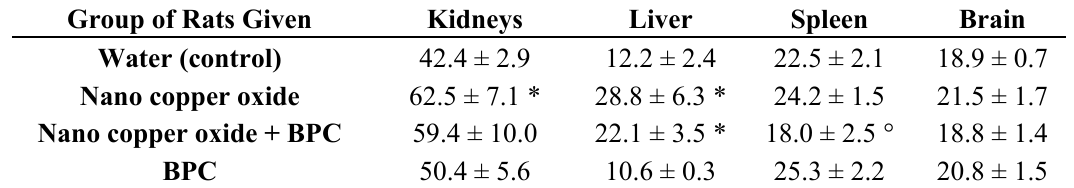
Table 1. Copper content of kidneys, liver, spleen and brain (mcg/g of dry-frozen tissue) of rats after repeat intraperitoneal injections of copper oxide nano-suspensions and/or oral administration of the bioprotective complex (BPC) ( х ± S х